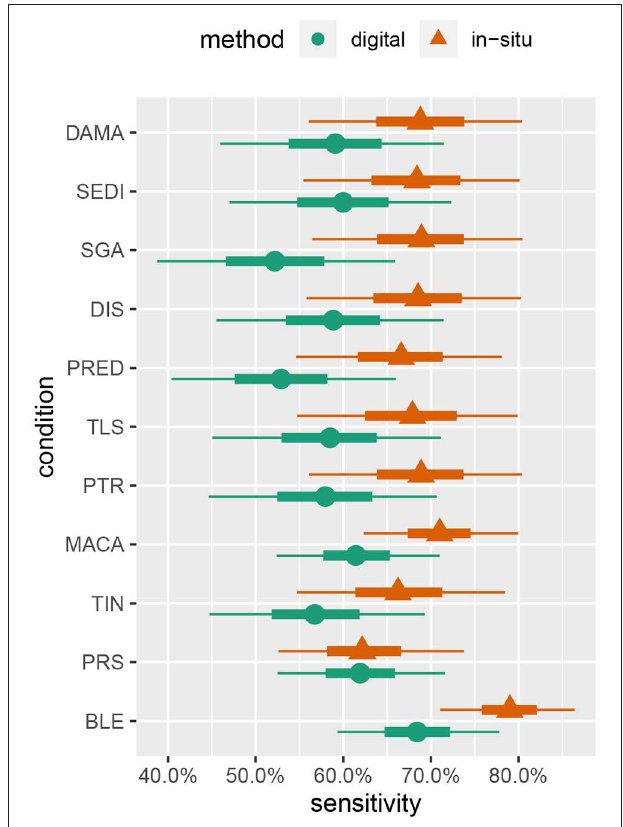
FIGURE 4 | Marginal posterior intervals for majority-rule sensitivity under the hierarchical model allowing sensitivity and specificity to vary by condition. Points indicate posterior medians, inner credible intervals are at the 50% level, and outer intervals are at the 90%